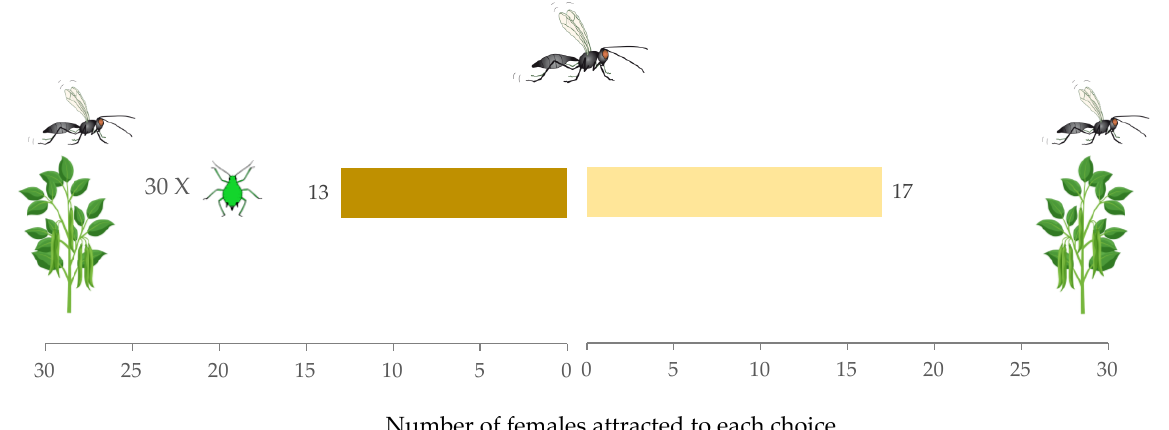
Figure 2. Response of Aphidius ervi females in a Y-tube olfactometer toward aphid-infested plant with conspecific female vs. non-infested plant with conspecific females.